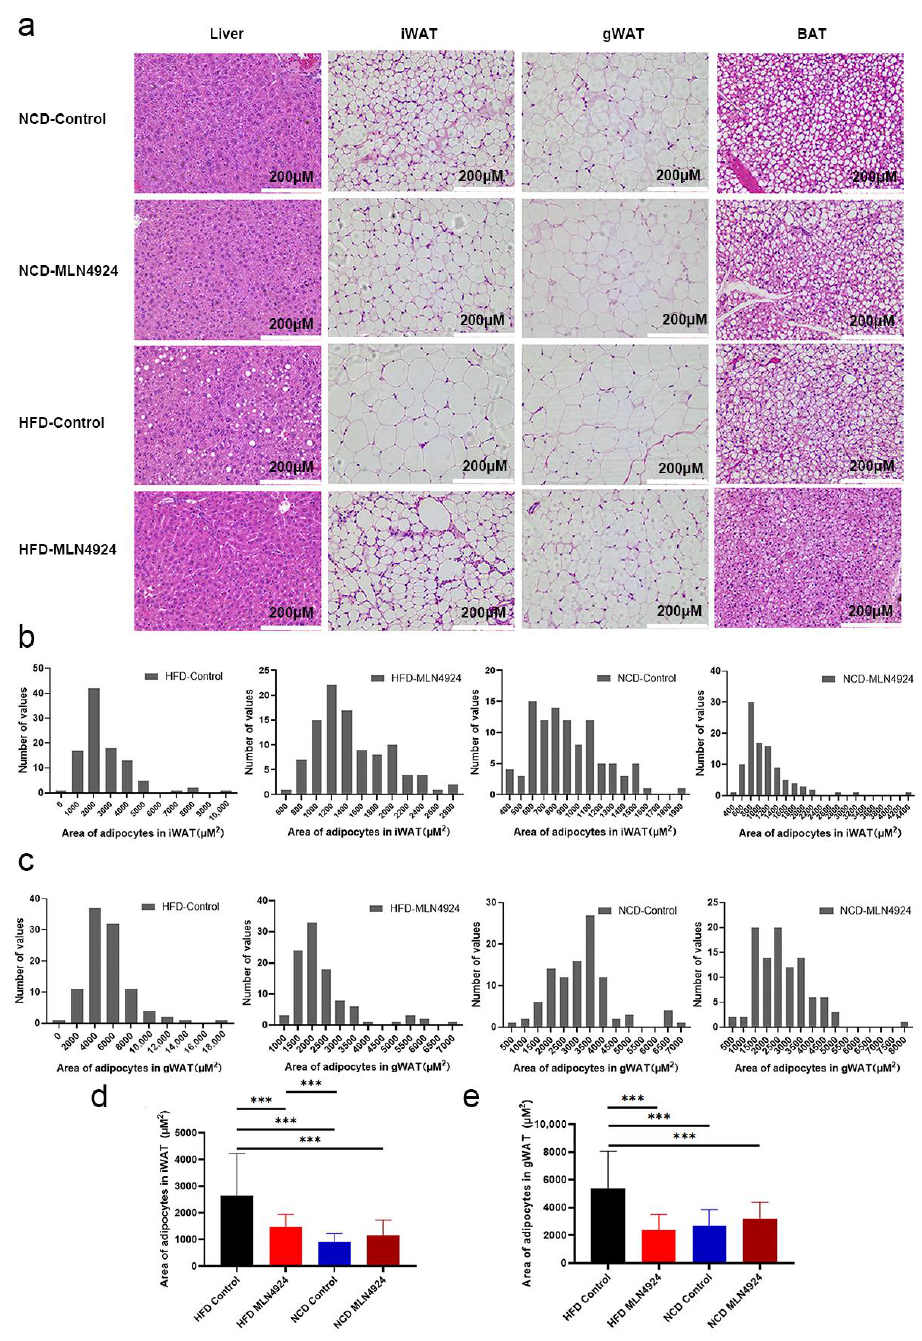
Figure 4. The generation and/or accumulation of lipid droplets in tissues of mice can be influenced by MLN4924. ( a ) Representative image of liver and adipose tissues and H & E staining are shown. ( b , c ) The statistical distribution map of adipocytes area of iWAT and gWAT in four groups were presented. ( d , e ) Statistical analysis of area of lipid droplets in iWAT and gWAT were presented. Data represents the mean ± SD, n ≥ 3. One-way ANOVA was used for statistical analysis (*** p < 0.001).